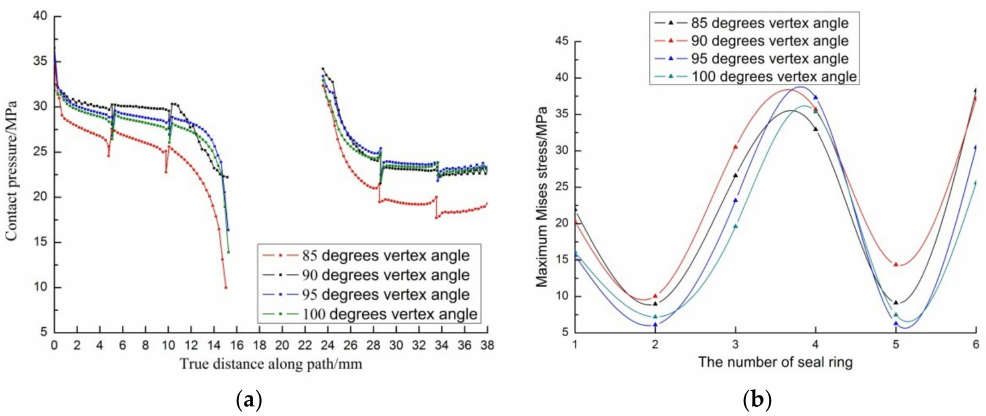
Figure 9. The stress distribution curve of sealing ring under different vertex angle: ( a ) contact stress distribution curve; ( b ) Mises stress distribution